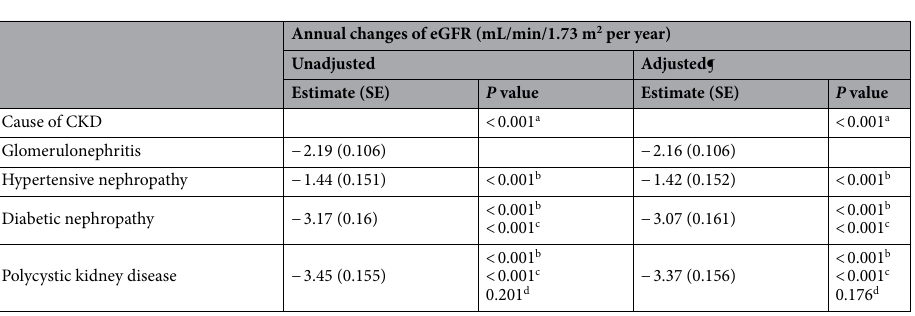
Table 4. Annual changes in eGFR according to the cause of CKD. ¶ Adjusted with age, sex, body mass index, CKD stage, mean blood pressure, cardiovascular disease, hemoglobin, uric acid, calcium, phosphorous, albumin, total cholesterol, high-density lipid cholesterol, low-density lipid cholesterol, fasting blood sugar, intact parathyroid hormone, urine protein-to-creatinine ratio, high sensitivity C-reactive protein, diuretics use, statin use, and ACE inhibitor or ARB use. a P value for the interaction term between the cause of CKD and time effect in the mixed model. b P value for each estimated of CKD causes compared to the glomerulonephritis as reference. c P value for each estimated of CKD causes compared to the hypertensive nephropathy as reference. d P value for each estimated of CKD causes compared to the diabetic nephropathy as reference. ACE, angiotensin converting enzyme; ARB, angiotensin receptor blocker; CKD, chronic kidney disease; eGFR, estimated glomerular filtration rate; SE, Standard